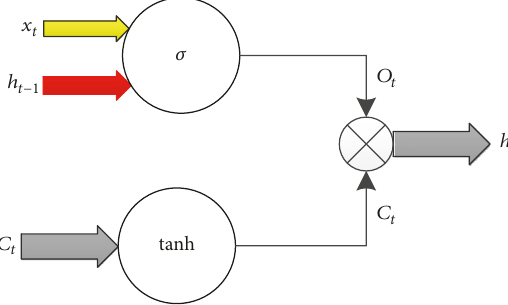
Figure 6: Architecture of the input gate in LSTM.